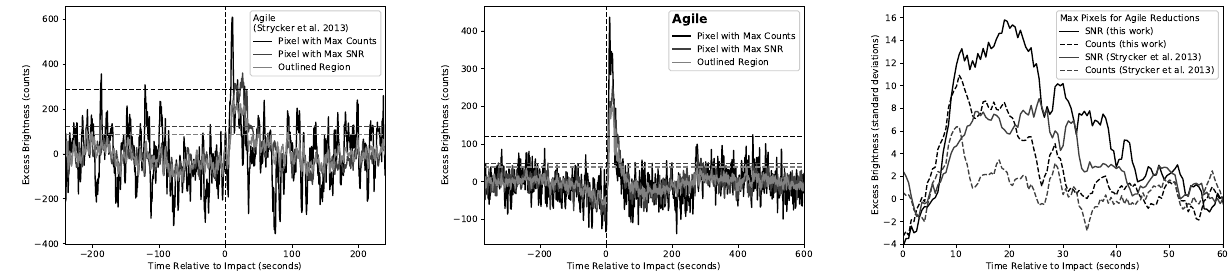
Figure 7. Comparison of the Strycker et al. [13] data reduction with that of this work. The lightcurves are from the locations indicated in Figure 4. The horizontal dashed lines give the 3 σ level for each